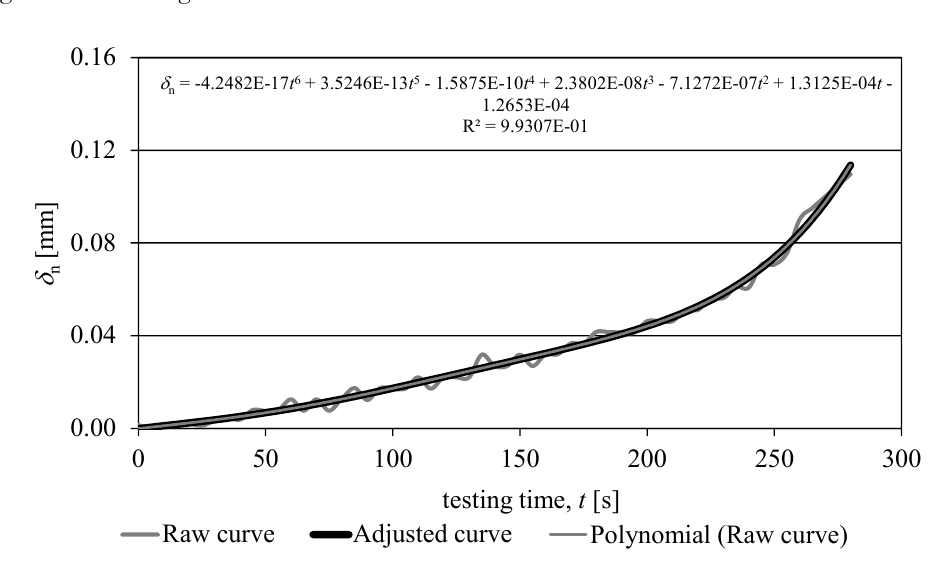
Figure 4: Evolution of  n for one test specimen: raw curve obtained from the optical method, polynomial fitting curve and corrected polynomial